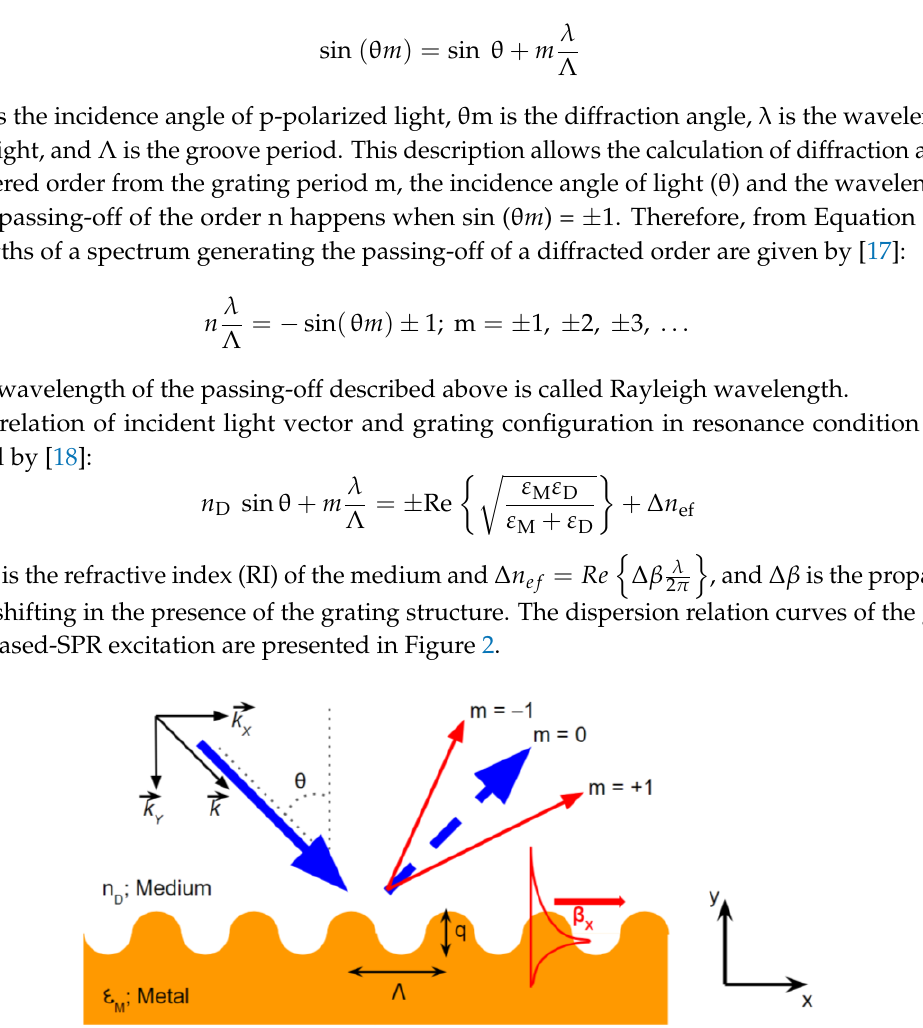
Figure 1. The configuration of the SP grating coupler.